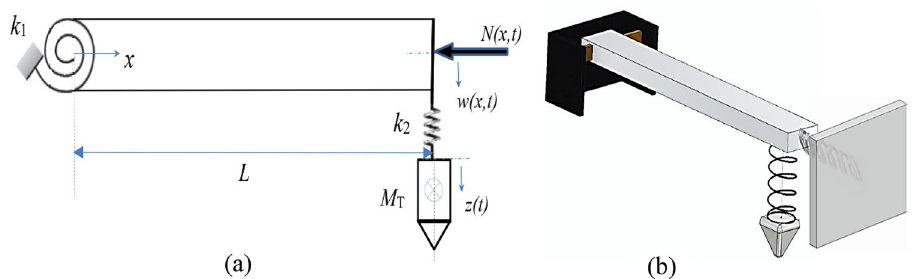
Fig. 1 Elastically restrained beam with concentrated axial load and spring-mass attached at free